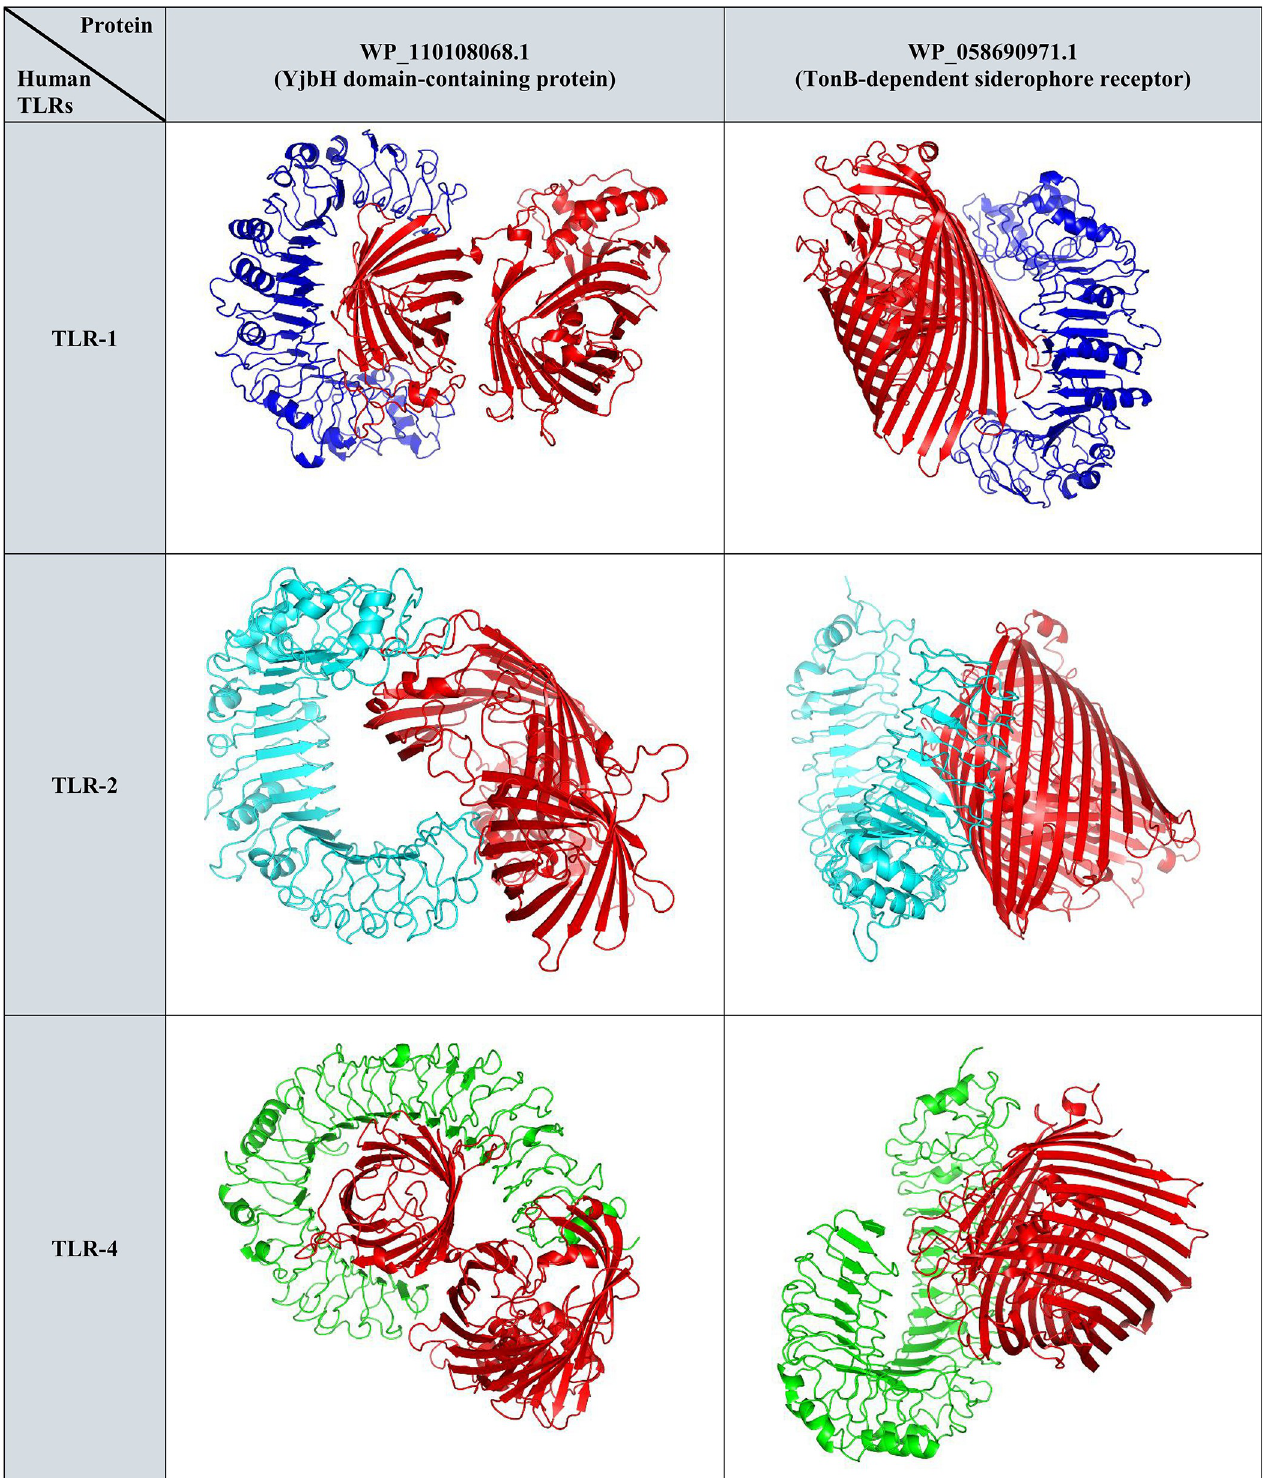
Fig 6. The interaction of WP_058690971.1 (TonB-dependent siderophore receptor) and WP_110108068.1 (YjbH domain-containing protein) with TLR- 1, 2 and 4.